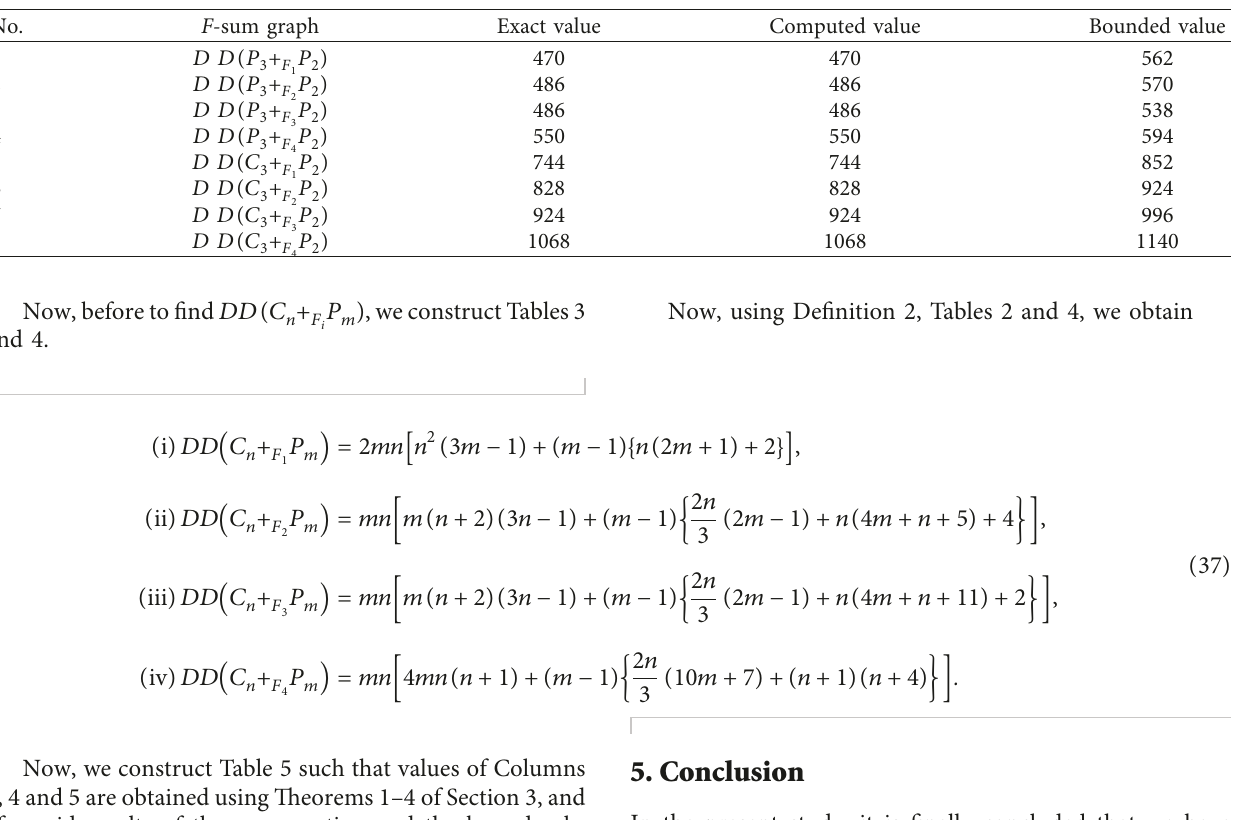
Table 4: Some particular distance sums of F ( C